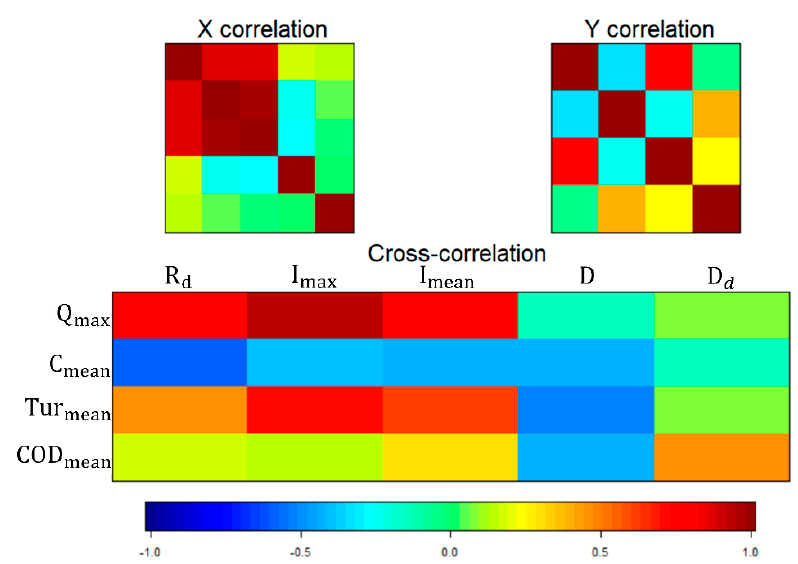
Figure 6. Correlation between rainfall and CSO variables in the El Vado CSO. The range of colors indicates the degree of correlation according to the graphic’s scale. The colors close to brown represent a strong positive correlation between the variables, while shades of dark blue instead represent a negative correlation. Cyan, green and yellow show low or no correlation between the variables.